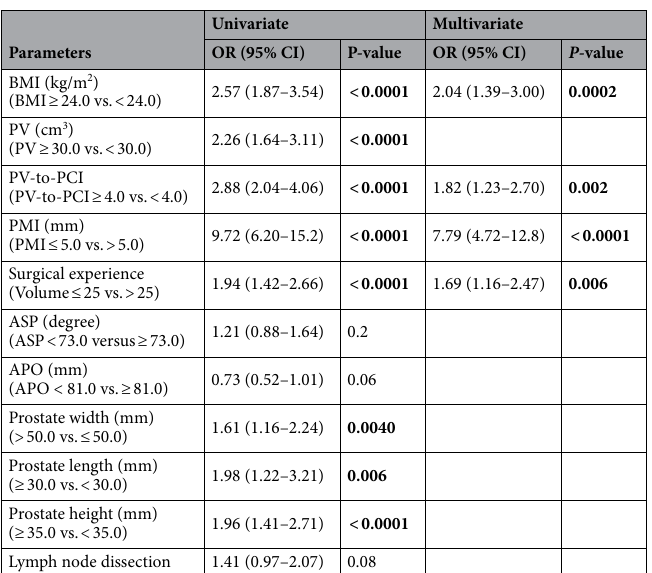
Table 2. Univariate and multivariate analyses of factors associated with ‘blood loss > 300 mL’ in the entire cohort including patients undergoing RARP with/without pelvic lymphadenectomy (N = 649). Logistic regression models were used for univariate and multivariate analyses. P -value of < 0.05 was considered to be statistically significant. OR Odds ratio, CI Confidence interval, BMI Body mass index, PV Prostate volume, PCI Pelvic cavity index, PMI Prostate-muscle index, ASP Angle of the symphysis pubis, APO Anteroposterior diameter of the pelvic outlet.